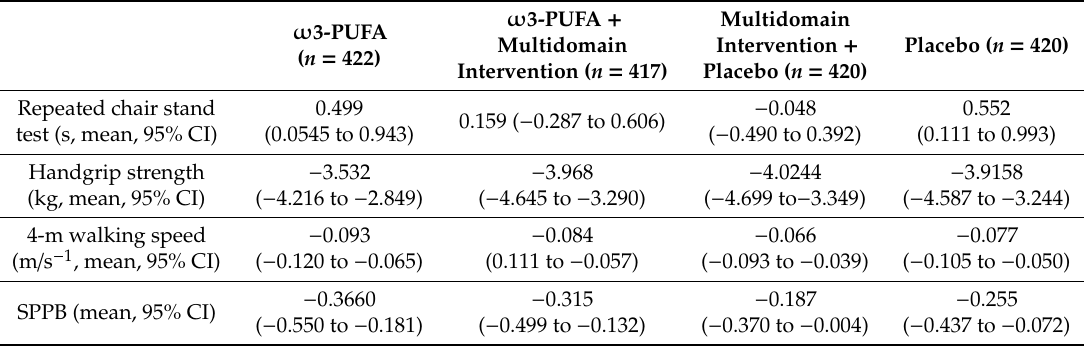
Table 2. Estimated 3-year within-group mean change in physical performance from baseline (95%